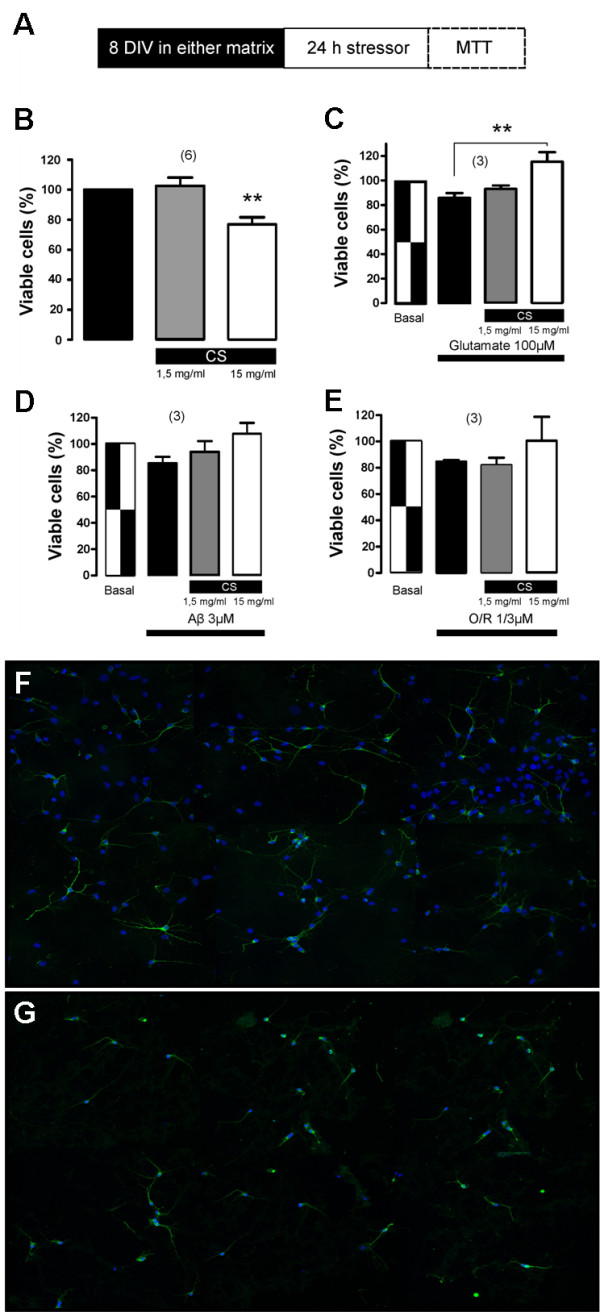
Effect of chondroitin 4-sulfate (CS) incorporated to nECM on hippocampal cell viability. (A) Experimental set up. After one week on CS-containing nECM and 24 hours of stressor treatment, hippocampus cell viability was measured by MTT assay. (B) Percentage of viability of hippocampal cells cultured on nECM in the absence (black bar) or presence of CS (1.5 mg/ml, grey bar; 15 mg/ml, white bar). (C) Percentage of viability of hippocampal cells cultured on nECM in the absence/presence of CS and in the absence/presence of 100 μM glutamate treatment. In each case, the treatments applied are described below bars. (D-E) Same as previous but this time in the presence of 3 μM amyloid beta 23:35 peptide (Aβ) (D) and 1 μM oligomycin plus 3 μM rotenone (O/R) (E) for 24 h. ** 0.001 < P < 0.01. The numbers between brackets on top of panels B-D show the number of independent experiments performed in each case. (F-G) Composite image containing immunofluorescence images of cells cultured on control nECM (F) and on 15 mg/ml CS-containing nECM (G). Cells were immunolabelled with anti-MAP2 antibody (green) and nuclei counterstained with Hoechst (blue).